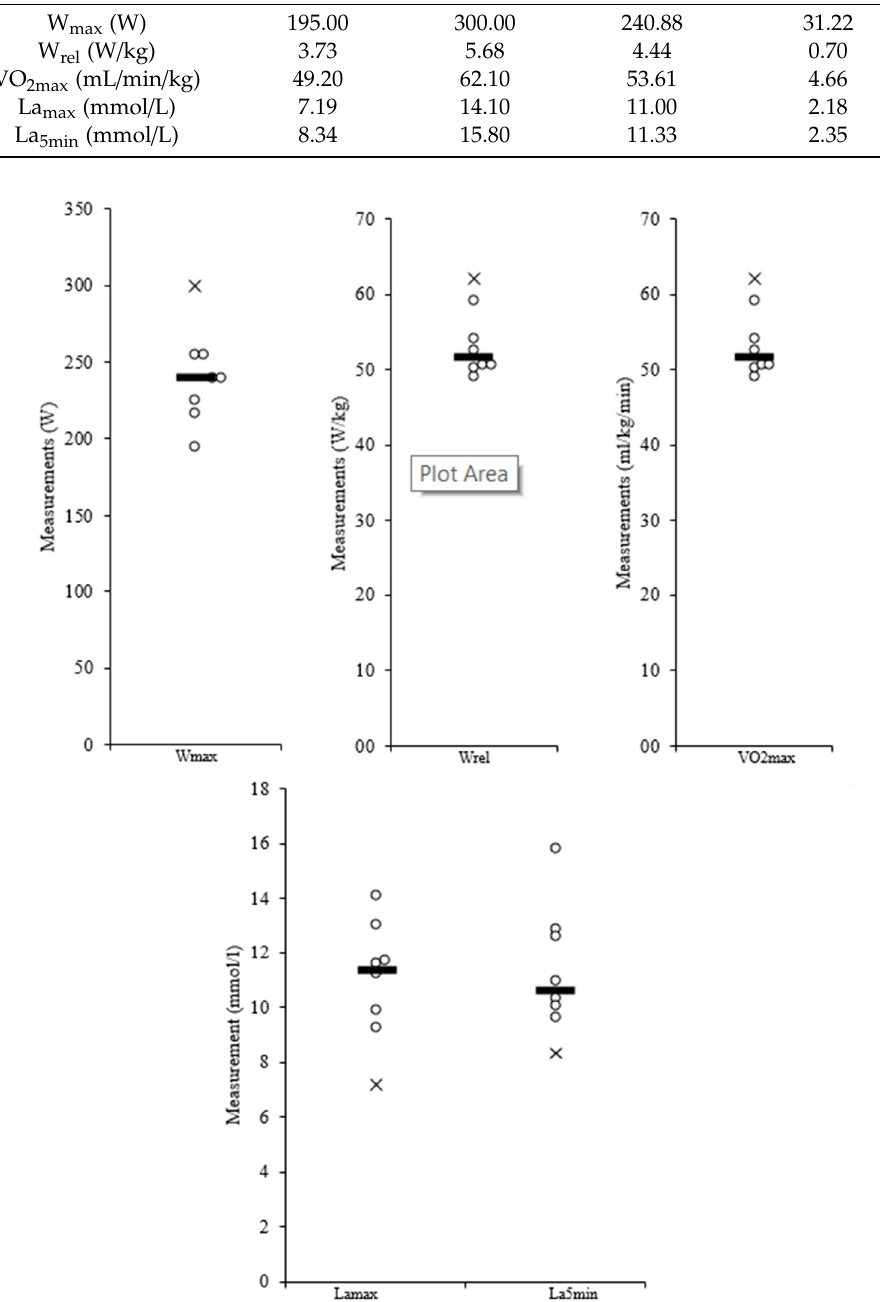
Figure 3. Scatter plots for performance-related parameters W max , W rel , VO2max, La max, and La 5min. The x is the value of the participant excluded from further analysis for performance